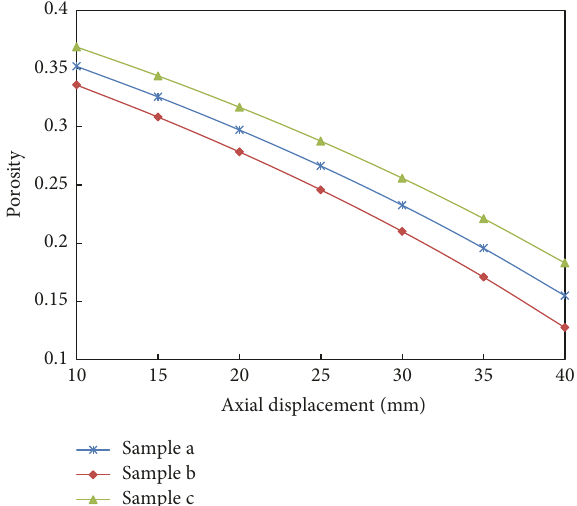
Figure 4: Porosity evolution under each axial